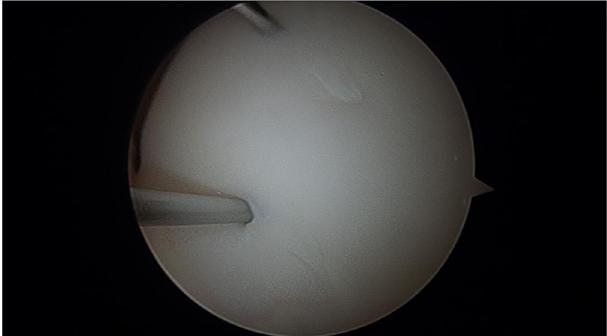
Figure 6. Provisional fi xation of the chondral fragment using k-wires.